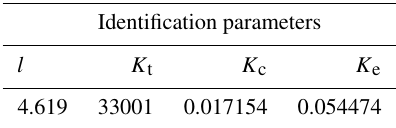
Table 1. Identification